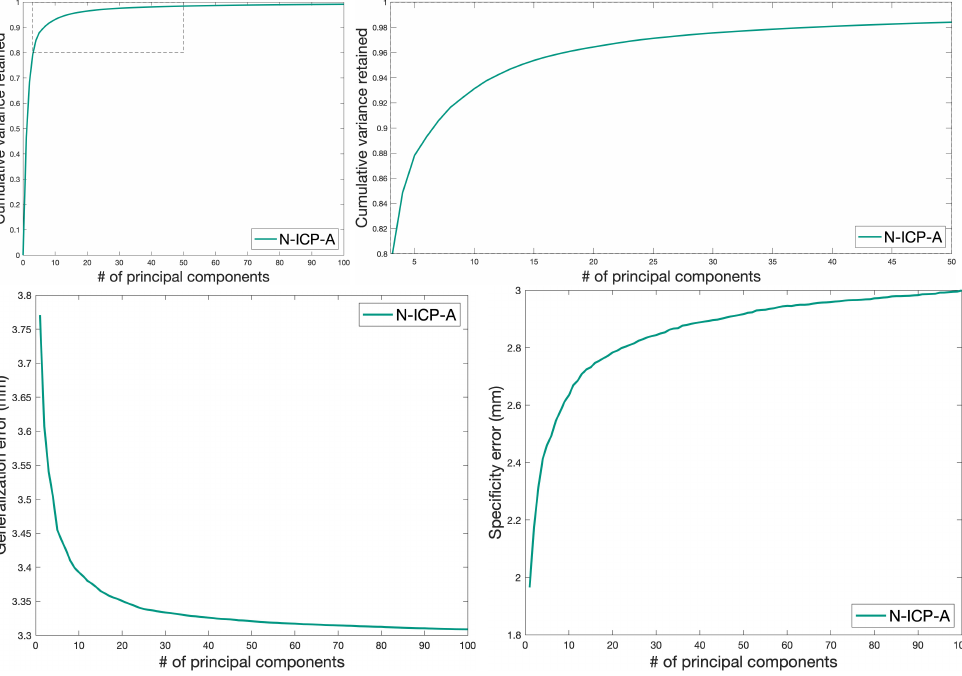
Figure 4. Compactness, generalization, and specificity of the final model as a function of the number of principal components. Top left : Compactness. Top right : Zoom-In. Higher is better. Bottom left : Generalization error. Bottom right : Specificity error. Lower is